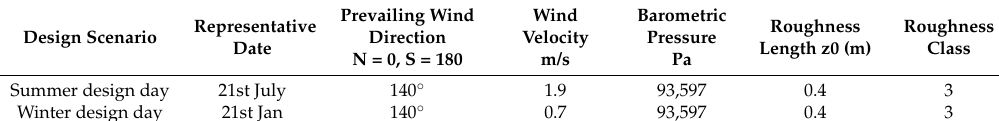
( b ) winter design day.